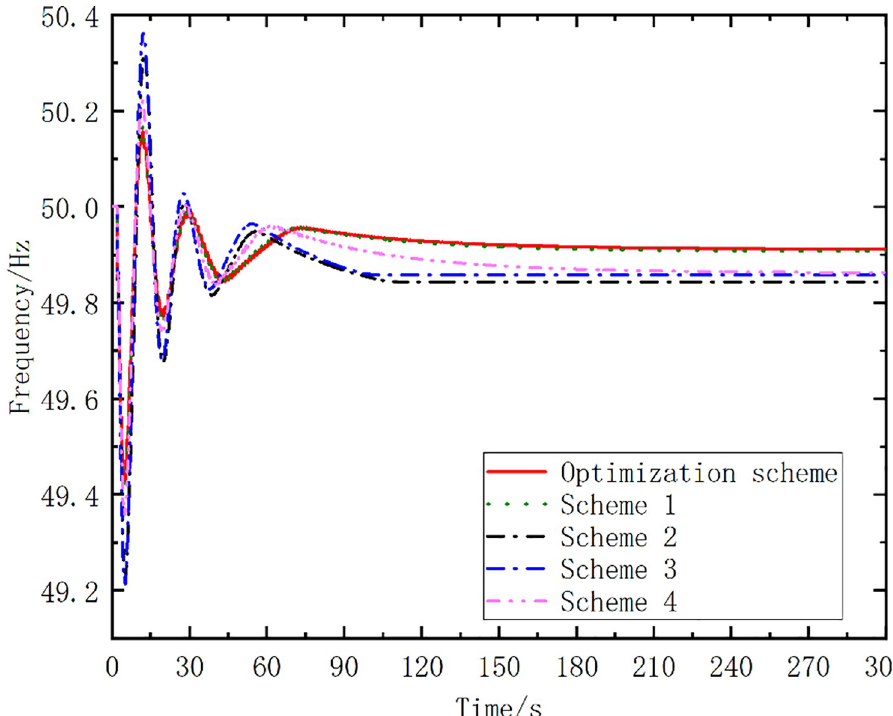
Fig 10. Simulated frequency curves for different